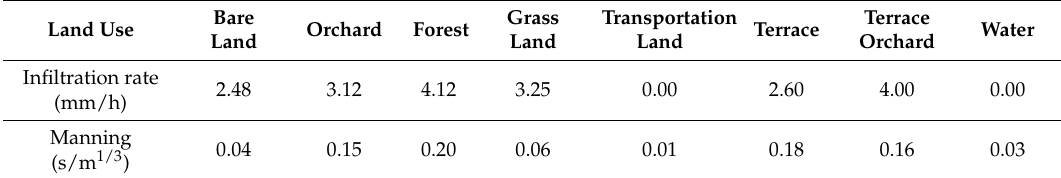
Figure 18. Comparison between the observed and simulated hydrographs.